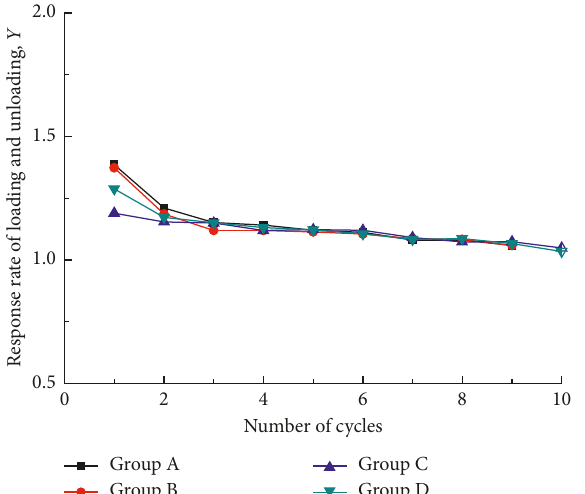
Figure 7: Curve of the response ratio of loading and unloading and cycles.